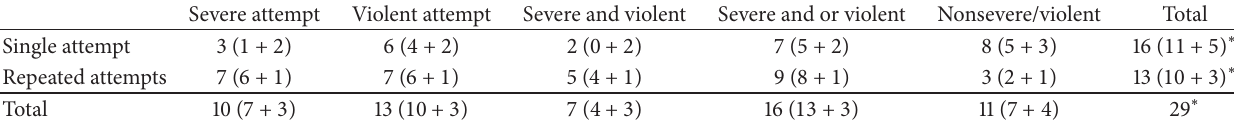
Table 2: Characteristics of suicide attempts: severity and violence related to repetition by individuals (women +